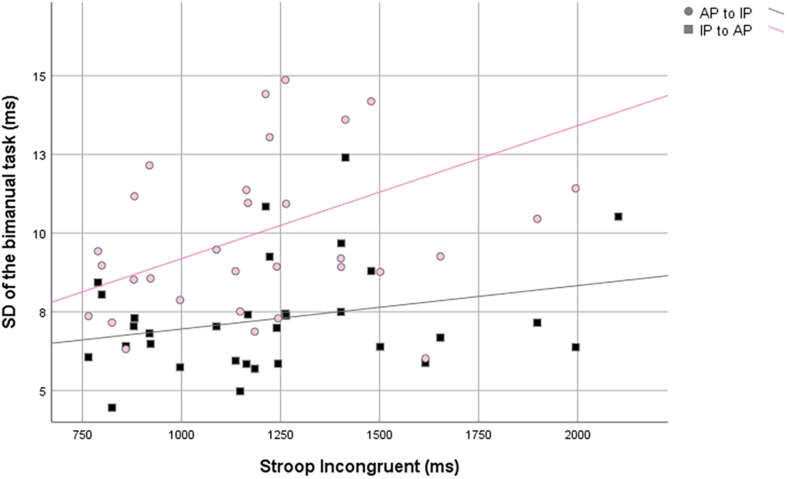
Scatter plots of the standard deviation of the relative phase against the Stroop incongruent condition.